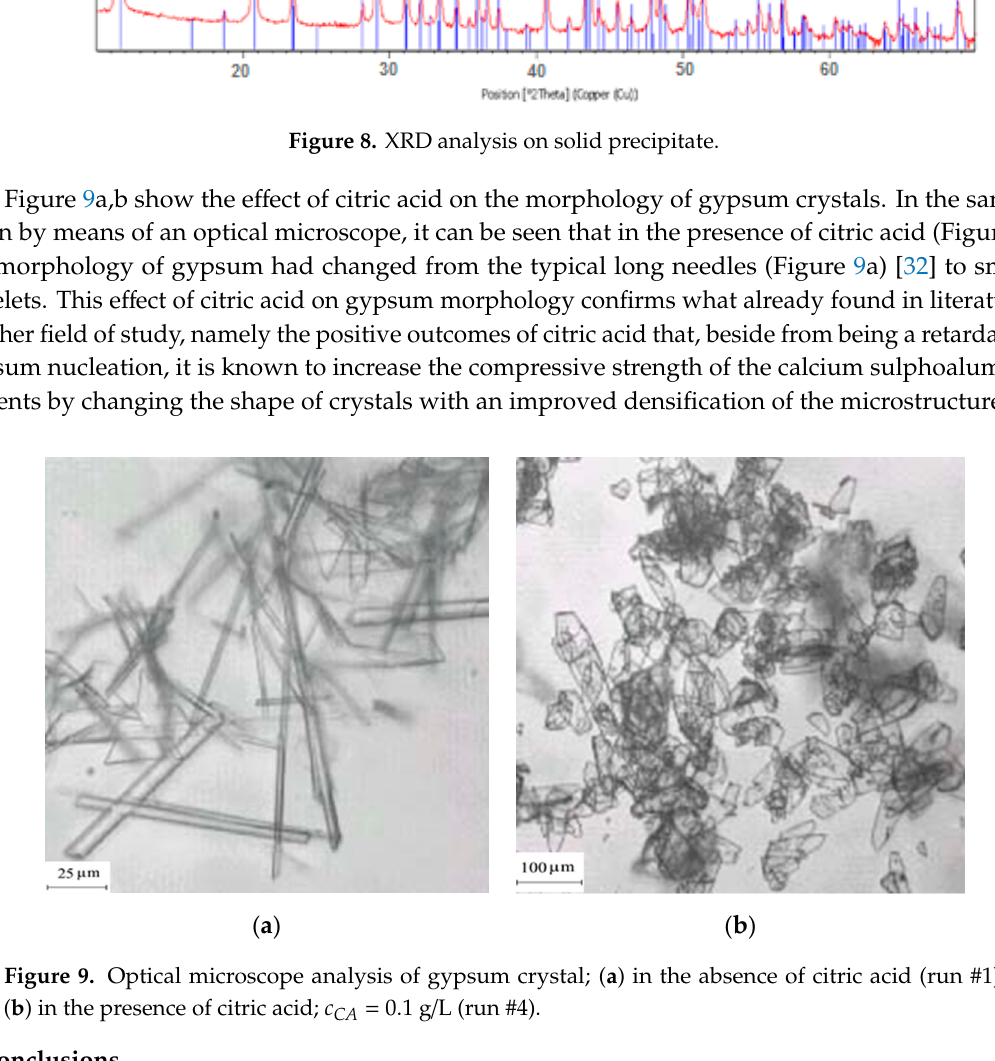
Figure 9. Optical microscope analysis of gypsum crystal; ( a ) in the absence of citric acid (run #1); ( b ) in the presence of citric acid; c CA = 0.1 g/L (run #4).